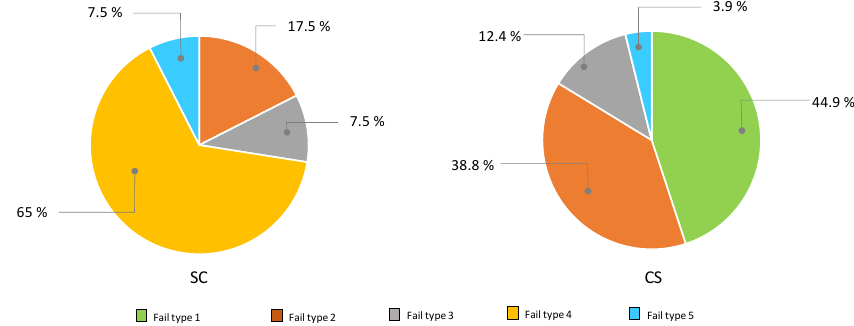
Figure 8. Distribution of unsuccessful grafts according to different causes, depending on the order in